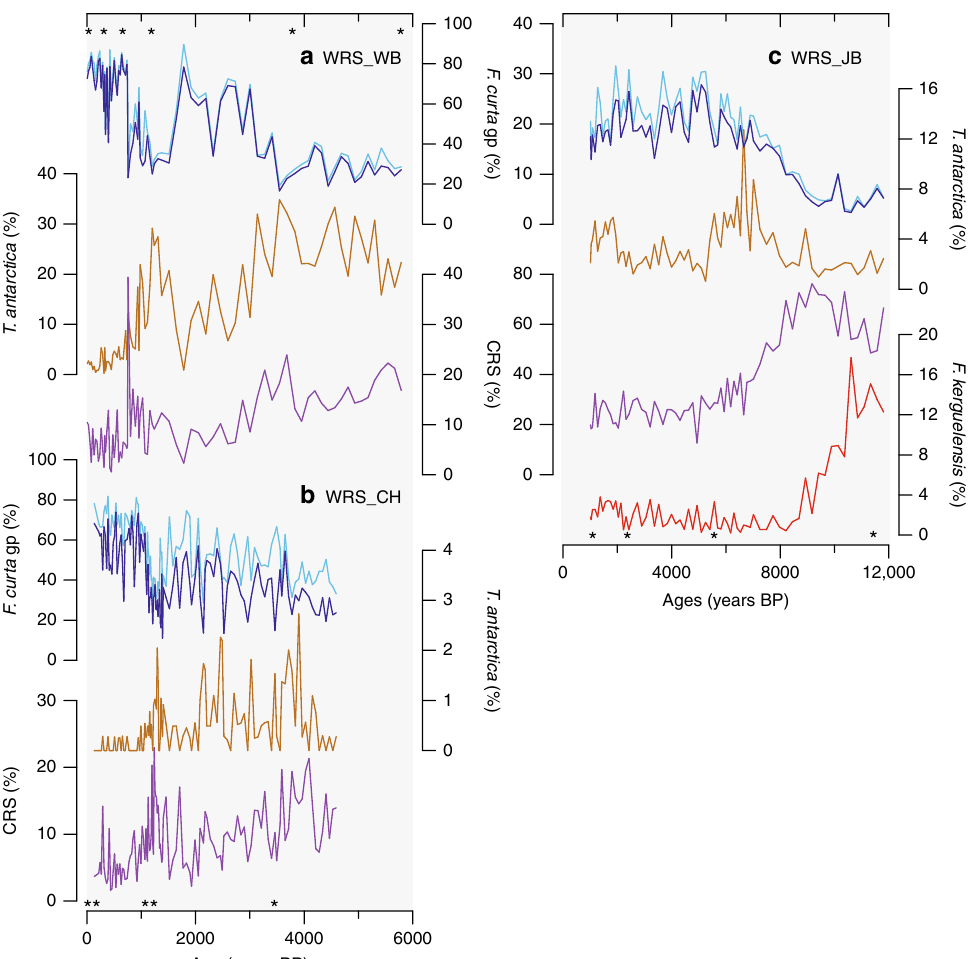
Fig. 2 Holocene diatom records. a Diatom relative abundances of Fragilariopsis curta (dark blue line) and the F. curta + F. cylindrus gp (light blue line), Thalassiosira antarctica resting spores (brown line) and Chaetoceros Hyalochaete resting spores (purple line) in core WRS_WB (BAY05-43c) from Wood Bay. b Similar to a but in core WRS_CH (BAY05-20c) from Cape Hallett. c Similar to a but in core WRS_JB (ANTA99-cJ5) from Joides Basin, with the addition of F. kerguelensis relative abundances (red line). Stars represent the calibrated 14 C ages for each marine